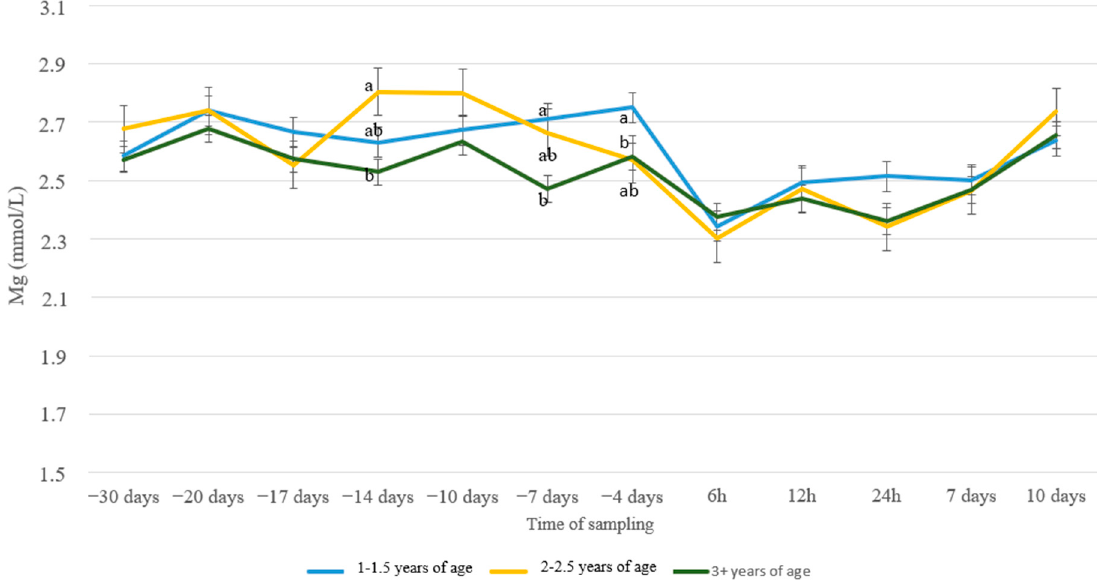
Figure 4. Mg levels (mmol/L) in blood serum of sheep in age groups 1–1.5 ( n = 35), 2–2.5 ( n = 11) and 3+ ( n = 41) years old during the peri-parturient period. a,b Different letters denote significant differ- ences between groups within evaluation time ( p <